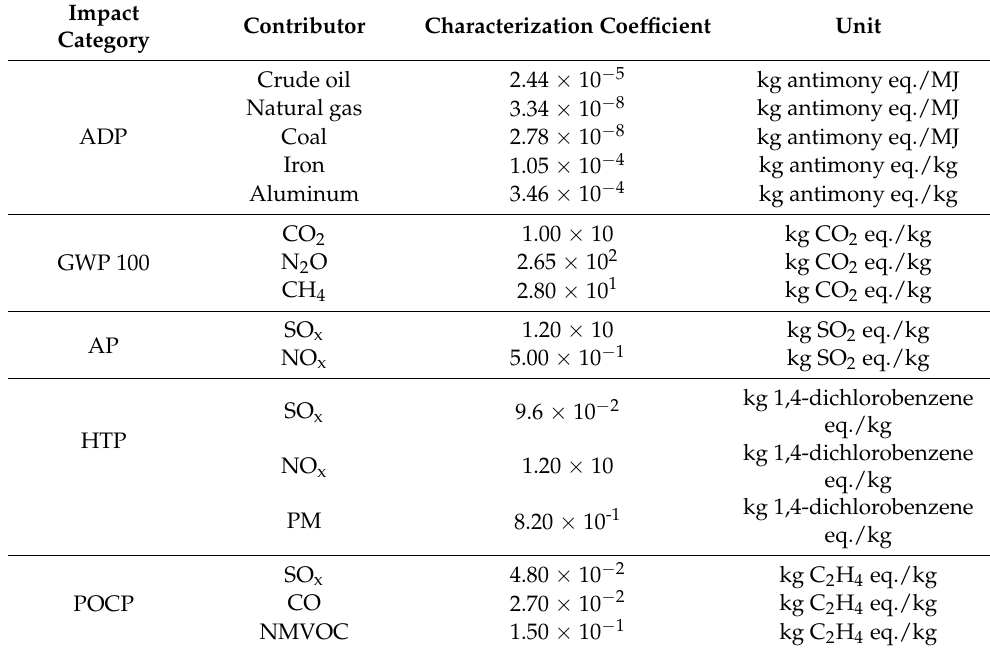
Table A3. Characterization factors of ADP, GWP 100, AP, HTP, and